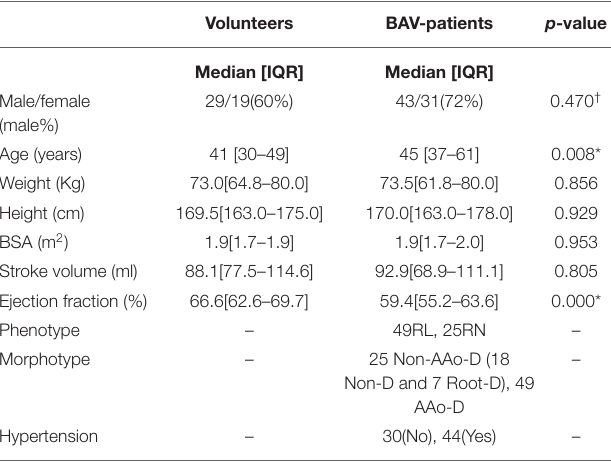
TABLE 1 | Volunteer and patient